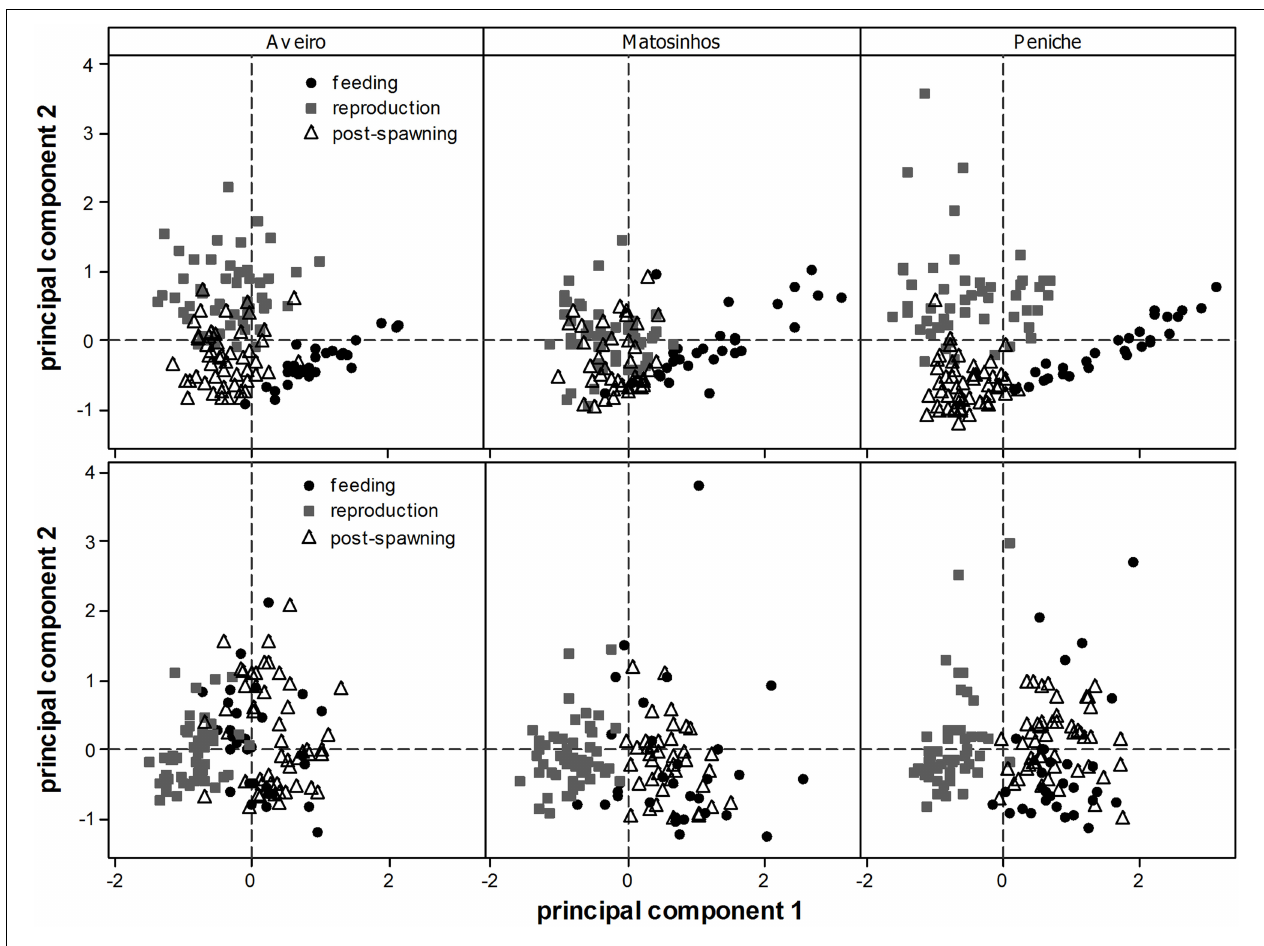
FIGURE 3 | Fish scores (from PCA) of three subpopulations of Sardina pilchardus (Aveiro, Matosinhos, and Peniche), illustrating their variation according to physiological (condition) and reproductive state (top panel; see also Figure 1A) and